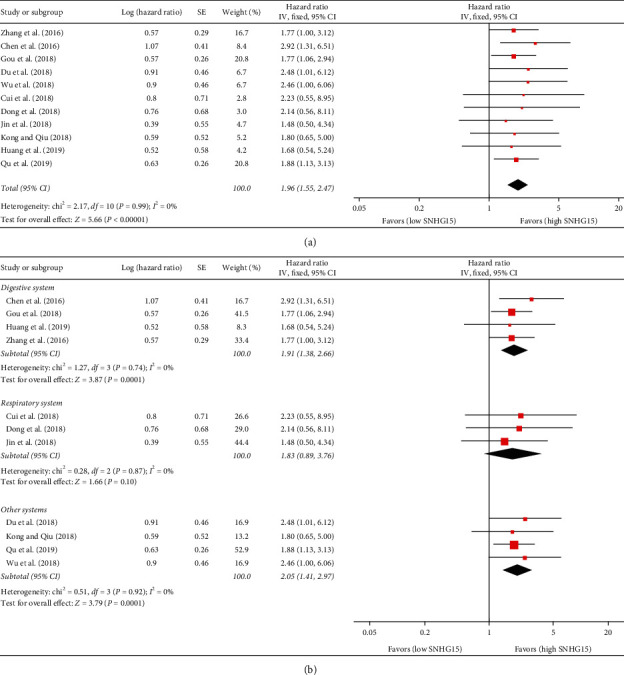
Forest plot for the association between SNHG15 expression and OS in (a) all cancer patients and (b) subgroup analysis based on different cancer types.